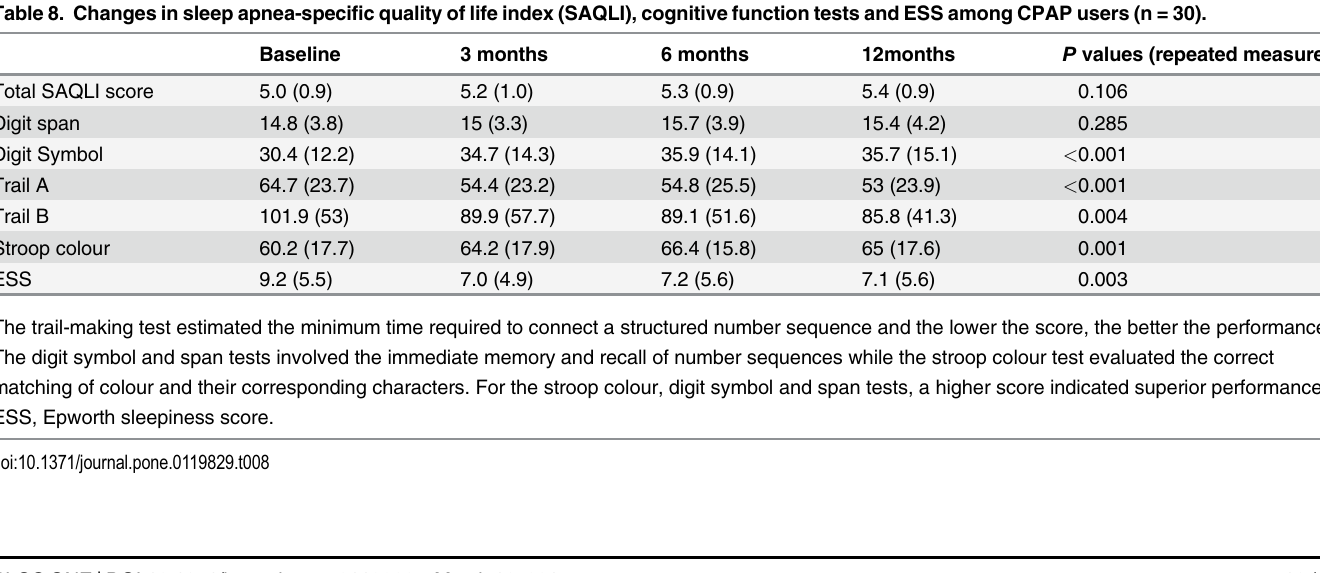
Table 8. Changes in sleep apnea-specific quality of life index (SAQLI), cognitive function tests and ESS among CPAP users (n = 30).